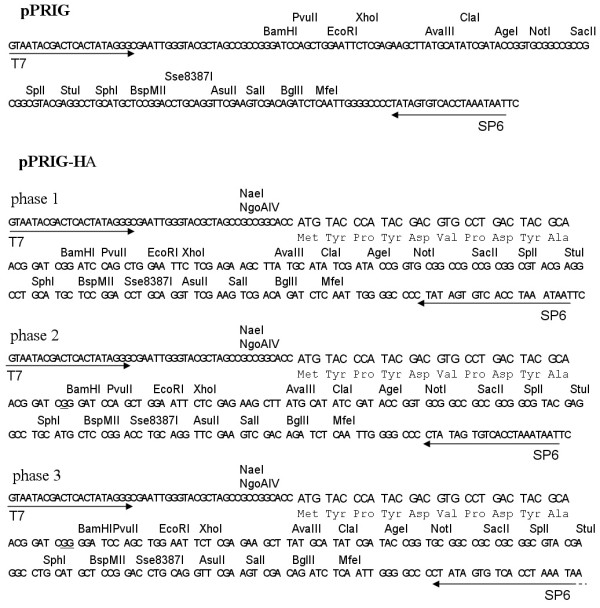
Structure of the four pPRIG vector polylinkers. pPRIG is the prototype polylinker, while the three pPRIG-HA vectors contain additional 1-nucleotide frame-shifted coding sequences for HA-tagging 5' of the polylinker sequence. Any insert can thus be cloned either in-frame downstream of this HA-tag, or directly into the pPRIG, without the HA-tag.